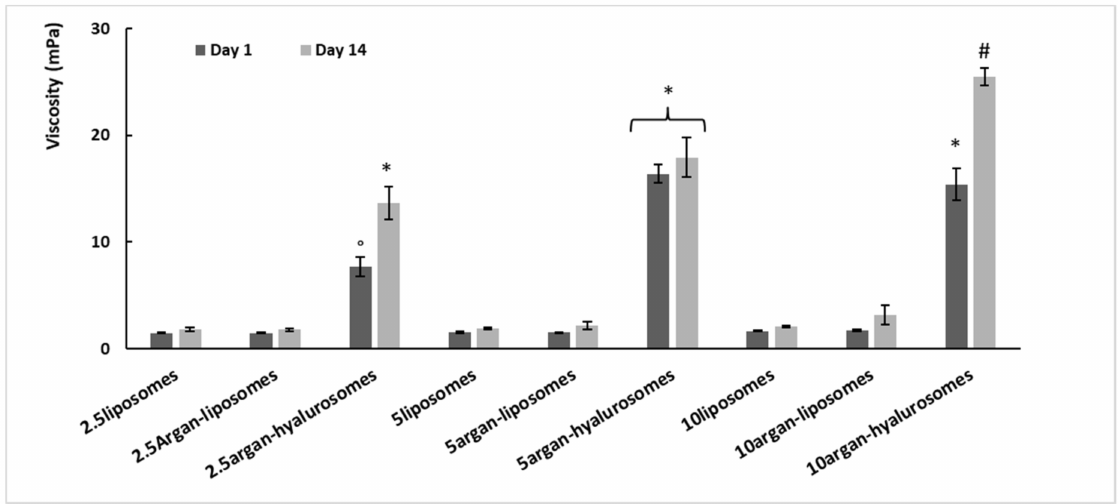
Figure 5. Viscosity values of liposomes, argan-liposomes and argan-hyalurosomes measured at 200 rpm, at day 1 and 14 of storage. Mean values ± standard deviations (error bars) have been reported. Symbols (*, ◦ , # ) indicate values statistically different ( p < 0.01).